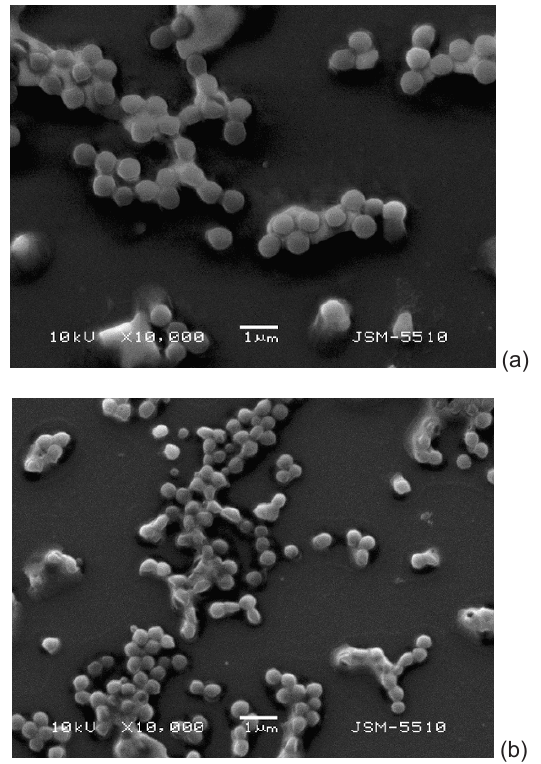
Figure 2. Representative SEM images of (a) pure PECA, and (b) CPX-PECA nanospheres. The samples are prepared with concentrations of ECA and CPX, both 10 mg mL -1